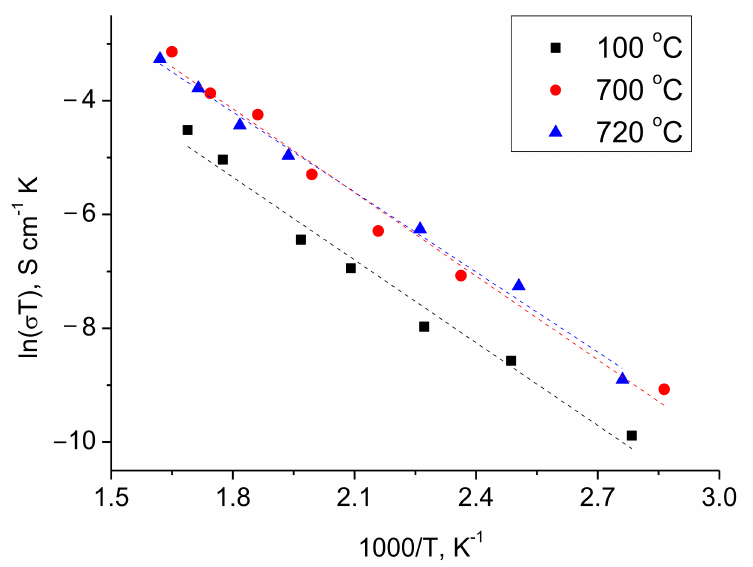
Figure 3. ArrheniusplotsforthetotalconductivityofLiCoO 2 |c-LLZhalf-cellsannealedatdifferenttemperatures. The typical impedance plots of LCO|c-LLZ and LCO/LBO|c-LLZ at 50 and 300 ◦ C are presented in Figure 4. The total resistance of the half-cells was determined from the intersection of the arc and low frequency tail with the real part of the impedance value Z (cid:48) . At close to room temperatures, the resistance values of the half-cell with lithium cobaltite could not be established due to the high interface resistance, Figure 4a, while the 5 wt% Li 3 BO 3 addition with subsequent heat treatment at 720 ◦ C led to a significant decrease in the interface resistance at the cathode–solid electrolyte even at 50 ◦ C. It can be seen that one semicircle is visible, but it does not come out of zero, Figure 4a. It was found that the resistance value between zero and the point of the semicircle beginning refers to the resistance of the c-LLZ since these values are in good agreement with the values measured separately for the solid electrolyte. Figure 4b also shows an equivalent circuit, according to which the total cell resistance is the sum of the resistance of the electrolyte and the resistance at the interface between the electrode and the solid electrolyte. According to the data obtained, the additive content as well as the heat treatment temperature of the half- cells affect the interface resistance between the solid electrolyte based on the Li 7 La 3 Zr 2 O 12 and LCO/LBO composite cathode. The optimal conditions for interface resistance decrease were reached using composite cathode with 5 wt% Li 3 BO 3 addition annealed at 720 ◦ C, Figure 5a. Apparently, the decrease in the sintering temperature for this composite cathode leads to a smaller contact area between cathode particles and ceramic electrolyte. To ensure a tight contact, either a larger glass addition is required (10 wt% LBO, Figure 5a,b) or a longer exposure time of sintering should be applied. Thus, a decrease in the interface resistance from 260 to 40 Ω cm 2 at 300 ◦ C is observed when a composite cathode with 5 wt% Li 3 BO 3 is applied, in comparison with pure lithium